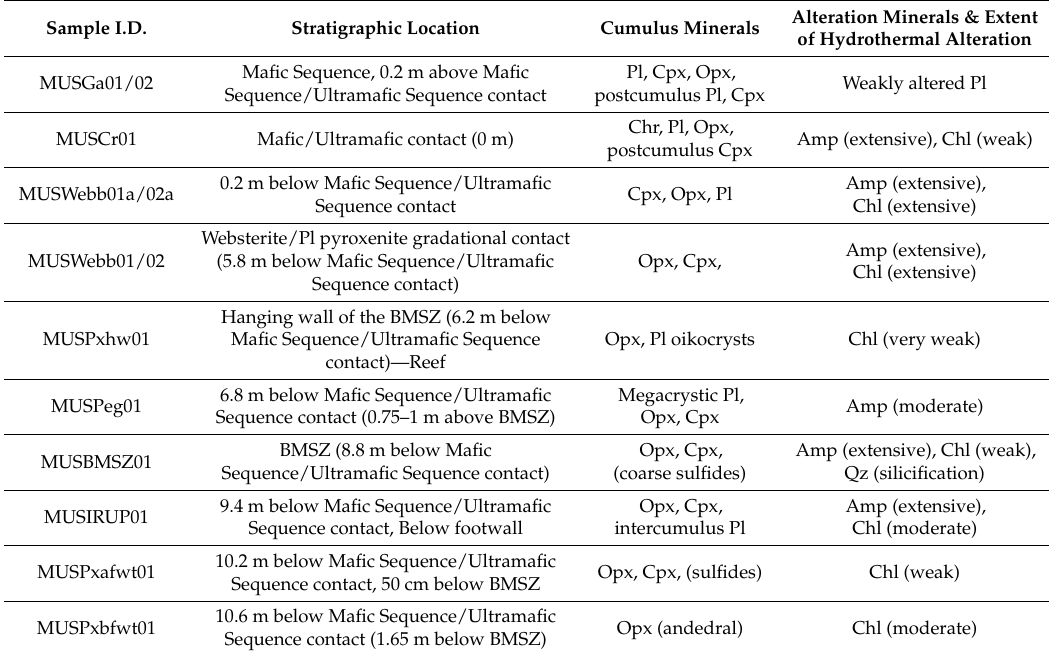
Table 2. Samples from Unki Mine MSZ and adjacent rocks, with cumulus minerals and hydrothermal alteration minerals